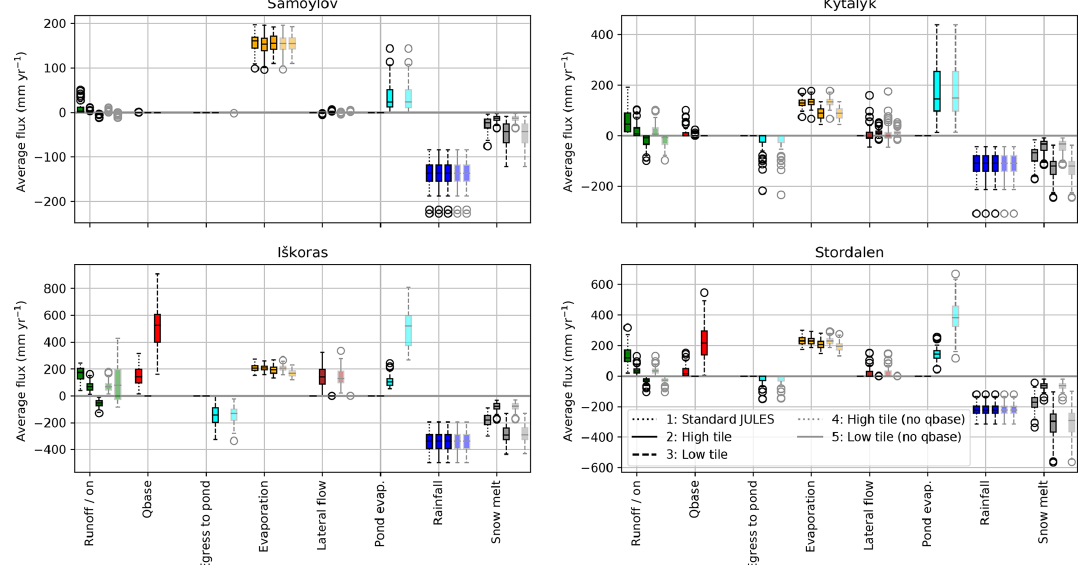
Figure B3. Average yearly simulated moisture fluxes for the period 1950–2016 for all sites with the qbase on configuration. Fluxes for the qbase off configuration (as in Fig. 8) are shown in grey for comparison.